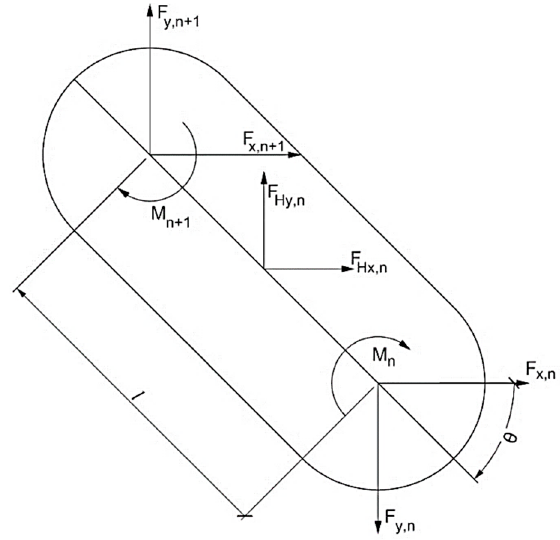
Figure 4. Segment free-body diagram.